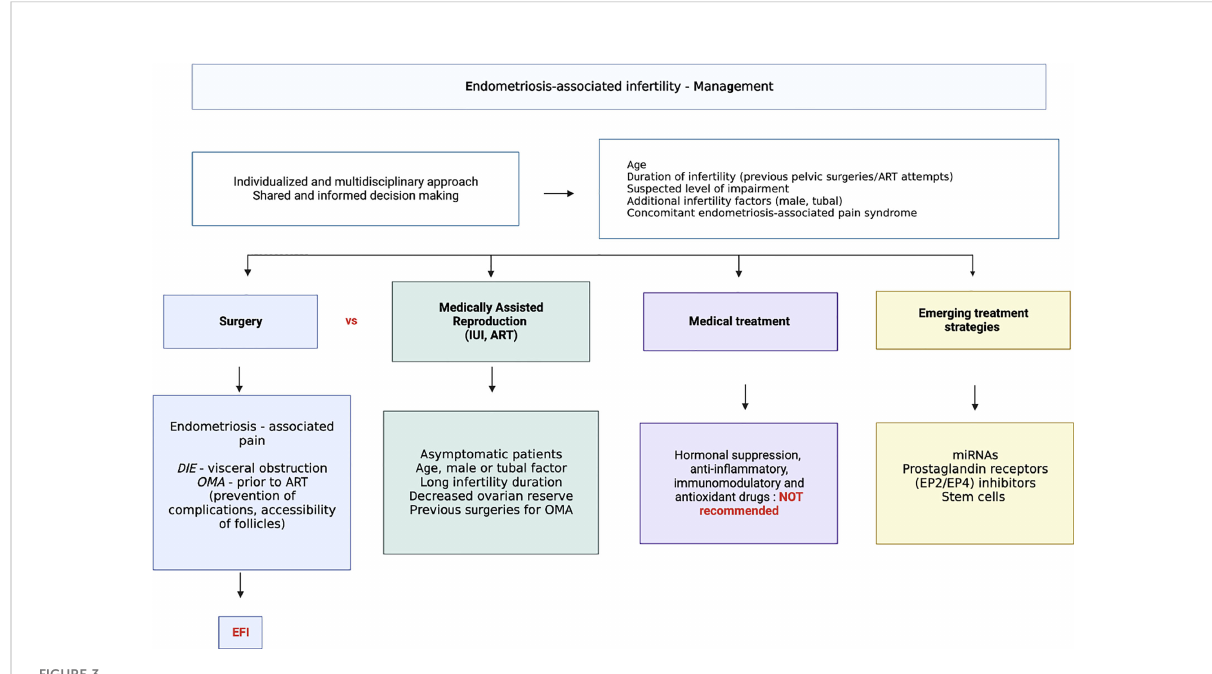
FIGURE 3 Current and emerging treatment options for endometriosis related